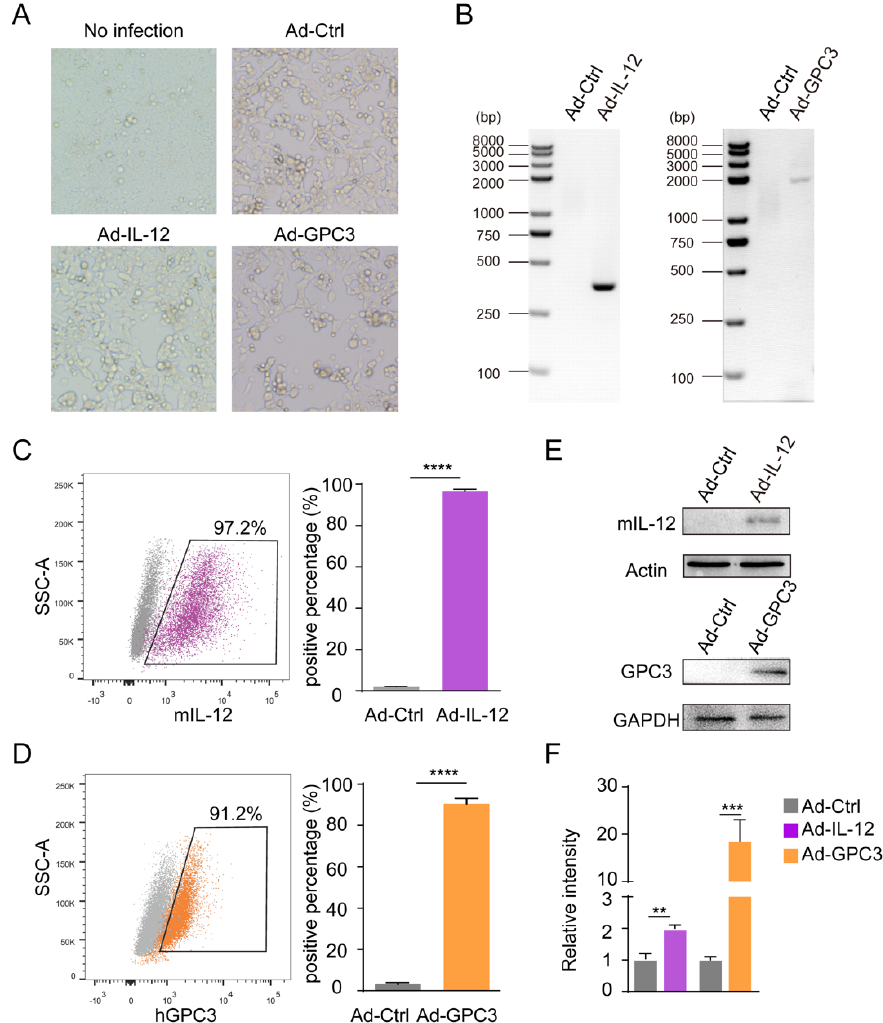
Figure 1. The construction and expression of Ad-IL-12 and Ad-GPC3. ( A ) The cytopathic effect (CPE) in 293 cells infected with Ad-Ctrl, Ad-IL-12, or Ad-GPC3. ( B ) Identification of the recombinant Ads by PCR. ( C , D ) The transduction efficiency of 293 cells infected with Ad-IL-12 or Ad-GPC3 was detected by flow cytometry, and the quantification of IL-12 or GPC3 expression was per- formed. ( E ) Western blot analysis of IL-12, GPC3, and GAPDH expression for muscular tissues from mice immunized with vaccines; Full pictures of the Western blots are presented in Figure S1. ( F ) Quantification of IL-12 and GPC3 expression by densitometry in ( E ); The densitometry read- ings/relative intensity of each band of the densitometry scans are presented in Table S1. Data are